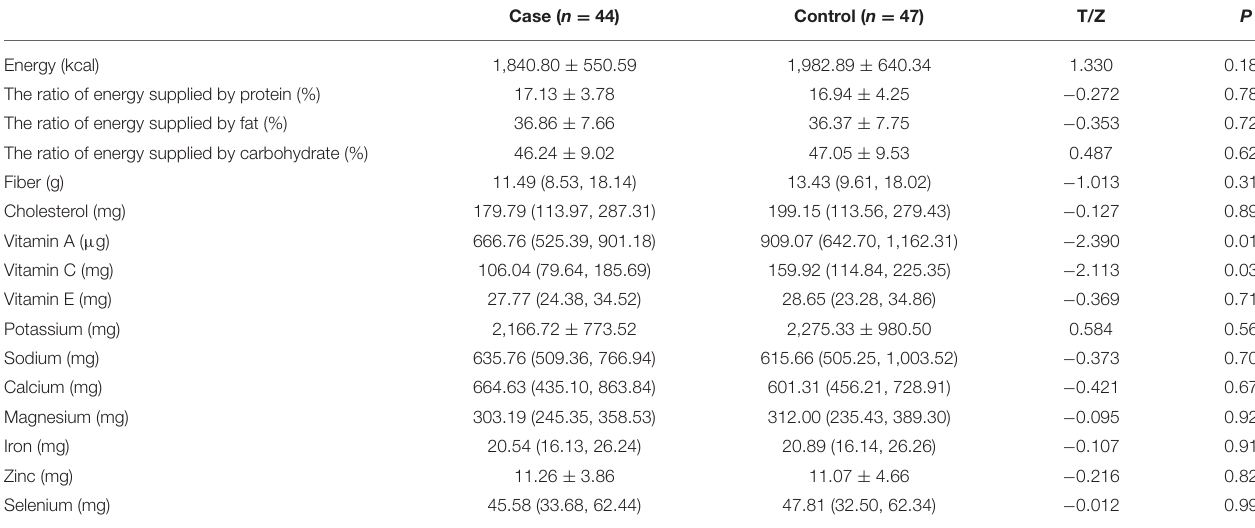
TABLE 2 | Comparison of dietary nutrient intakes per day between the two